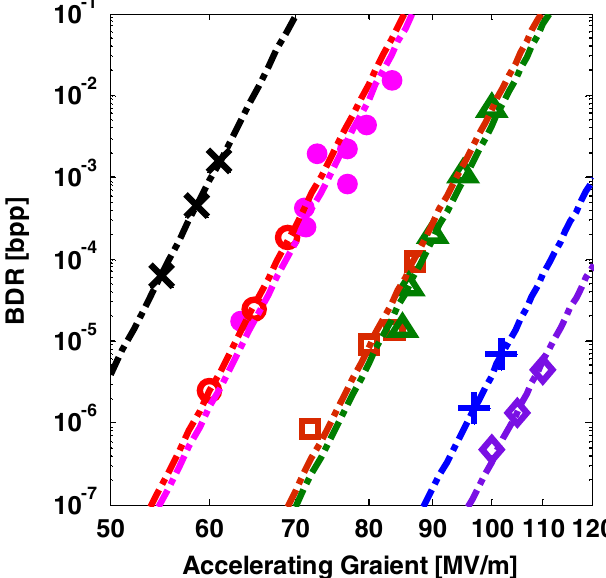
FIG. 1. (Color) Measured dependence of BDR versus gradient and the power fit for the structure number 19—( (cid:4) ), 10—( (cid:6) ), 20—( d ), 4—( h ), 17—( m ), 8—(+), and 3—( e ) from Table